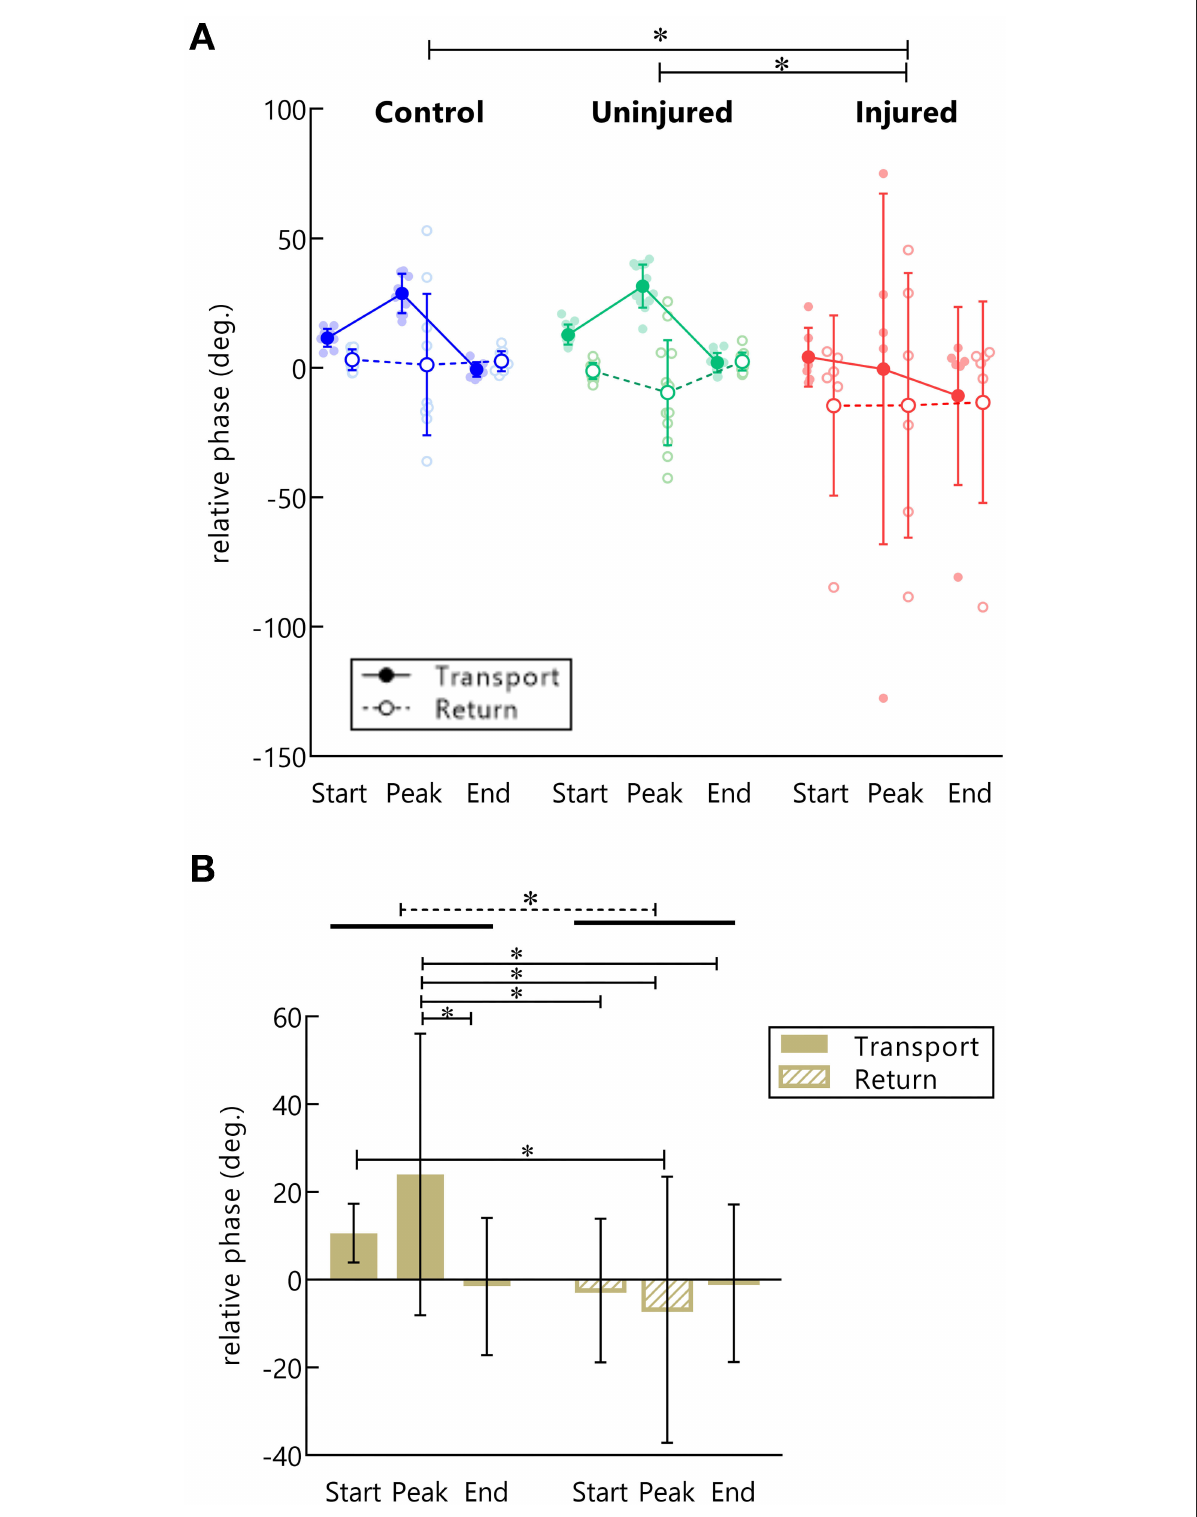
FIGURE5 RP in control, injured, and uninjured UL groups according to the movement (transport or return) and instants of hand movement (start, peak velocity, and end). (A) Each point represents the average RP per subject in the start, peak velocity, end of movement in hand transport to the mouth (filled dots), and return to the starting position (open dots). *Statistical difference between groups ( p < 0.05). (B) Main effect for movement phase. Mean RP is expressed as bars and SD. *Statistical difference between conditions ( p <